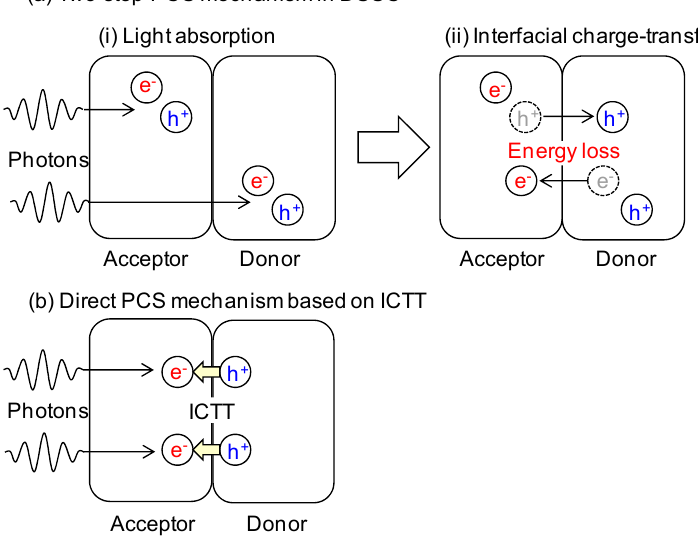
Figure 1. Schematic pictures of photoinduced charge separation (PCS) between heterogeneous electron-donating and -accepting substances. ( a ) Conventional two-step PCS mechanism and ( b ) direct PCS mechanism based on interfacial charge-transfer transitions (ICTT).